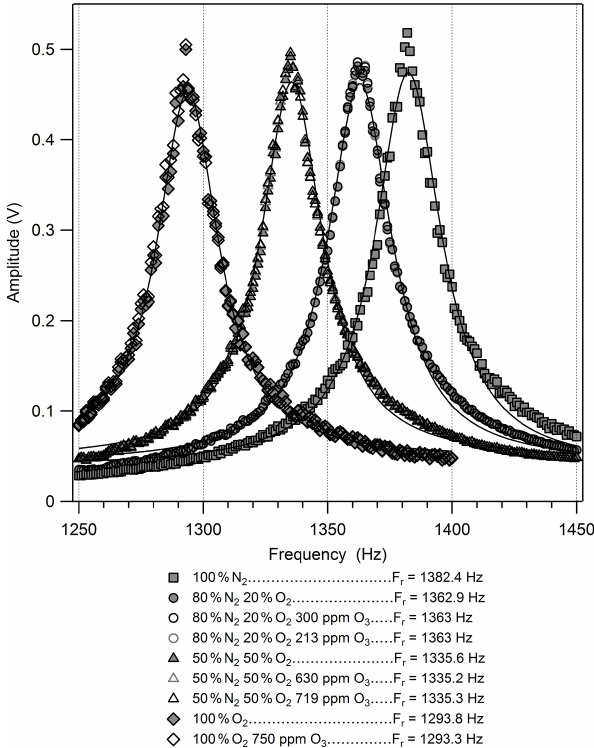
Figure 2. Fast Fourier transform (FFT) resultant power spectra with different carrier gas composition and O 3 concentration. O 3 was measured downstream to the PAS using the CRD-S, assuming O 3 σ abs of 1.5 × 10 − 23 cm 2 molecule − 1 from Axson et al. (2011).